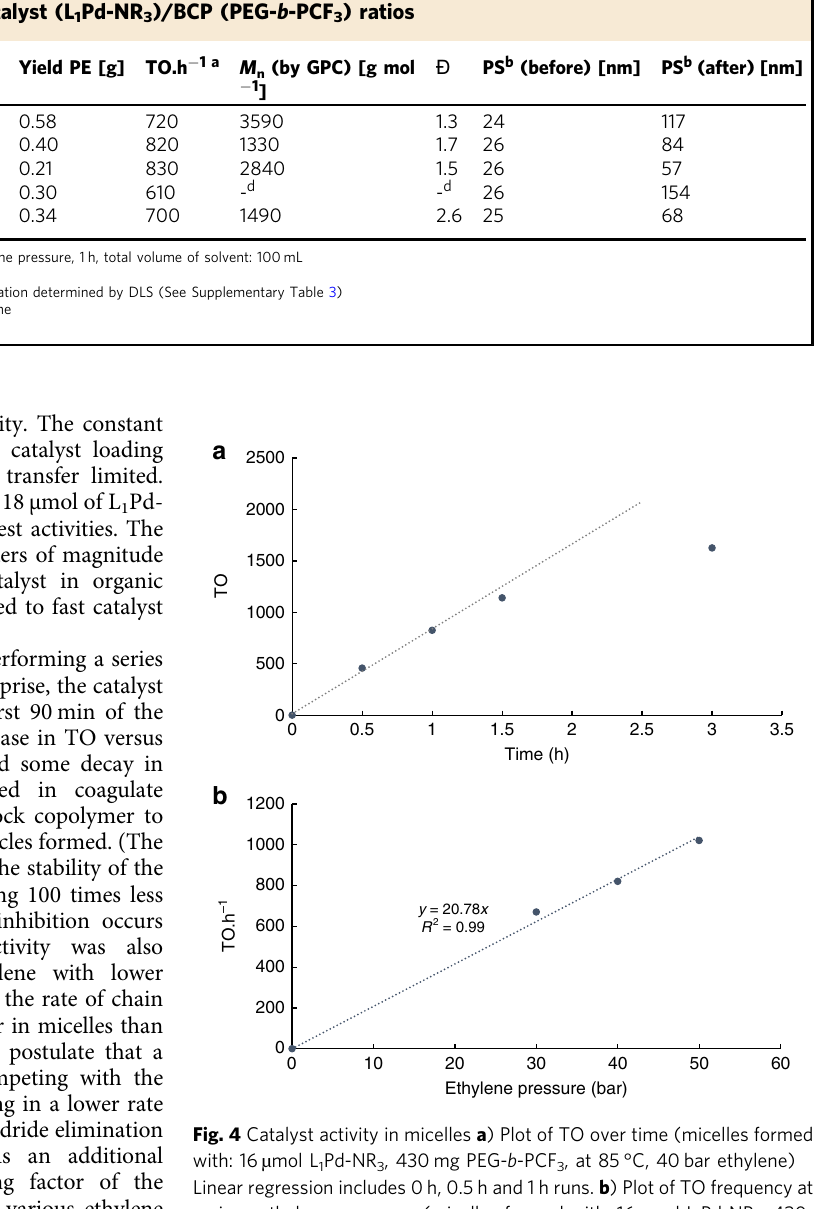
Table 2 Polymerization results for various catalyst (L 1 Pd-NR 3 )/BCP (PEG- b -PCF 3 ) ratios Entry Catalyst loading [ μ mol]